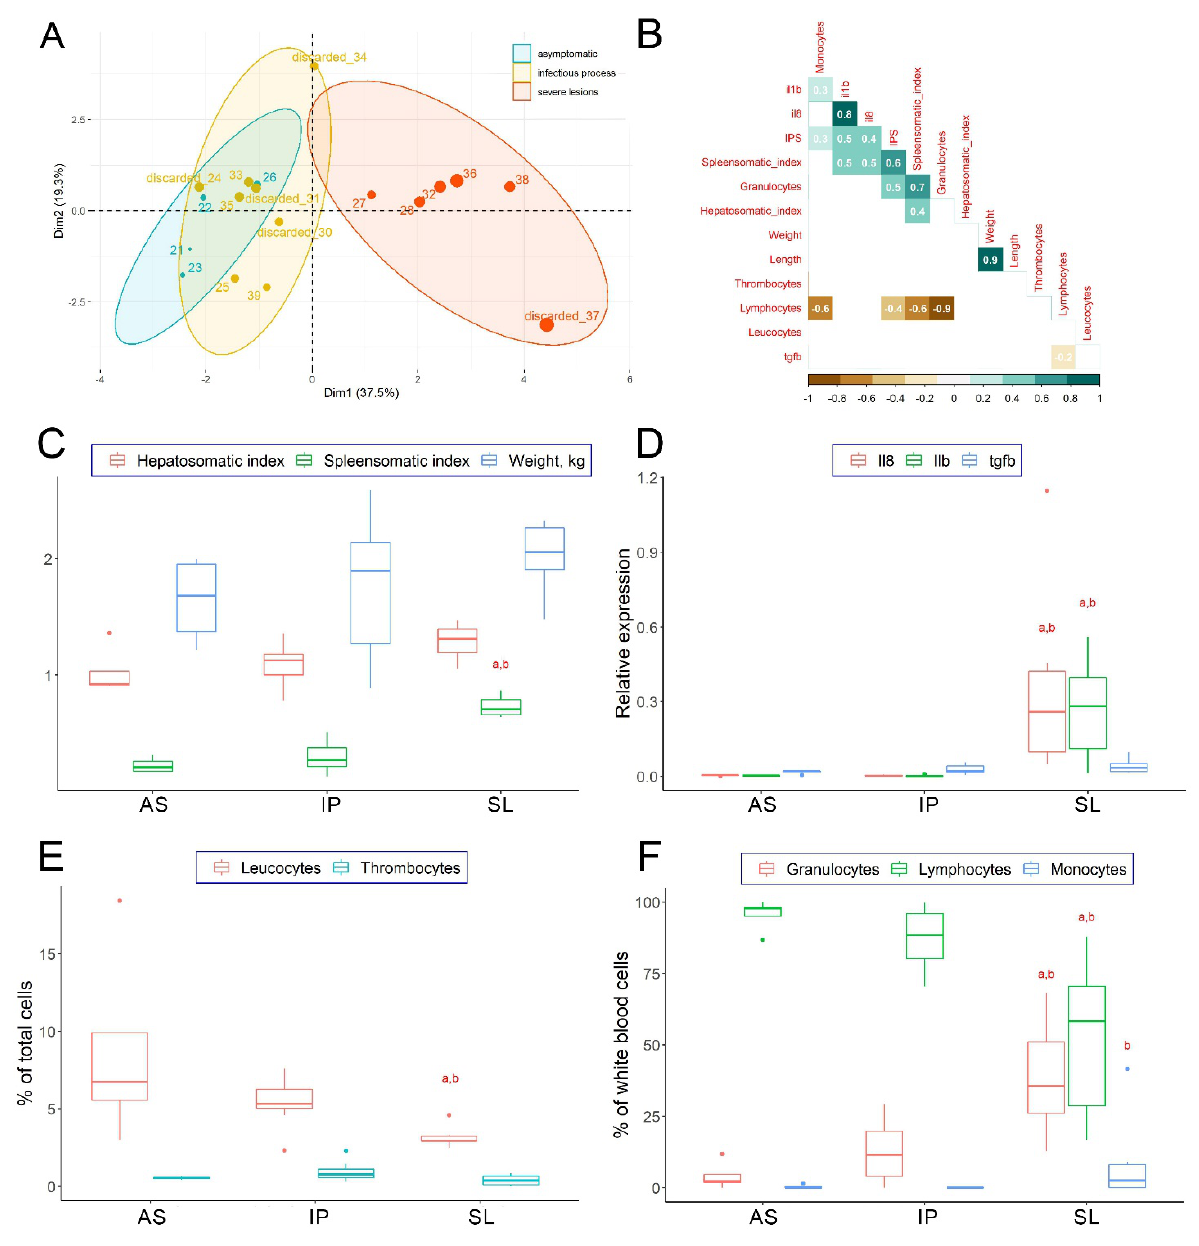
Figure 2. Assessment of the physiological state of rainbow trout collected on the farm during an outbreak of vibriosis (AS—asymptomatic, IP—with infectious process, SL—with severe lesions). ( A )—principal component analysis of the measured parameters of the physiological state of trout. Samples are colored by fish group; marker size corresponds to the IPS value. Samples not included in the proteomic analysis were denoted as “discarded”. ( B )—Spearman correlation matrix of mor- phophysiological parameters and biomarkers of immune response in collected rainbow trout. Only significant correlations are shown. ( C )—morphometric parameters of trout from groups with different severity of the infectious disease. ( D )—expression of immune-related genes in the spleen of trout from groups with different severity of the infectious disease. ( E )—relative numbers of white blood cells in trout from groups with different severity of the infectious disease. ( F )—types of leu- kocytes in the blood of trout from groups with different severity of the infectious disease. a—desig- nates statistically significant difference from the AS group, b—designates statistically significant difference from the IP group (Wilcoxon’s two-sample test, p < 0.05) .